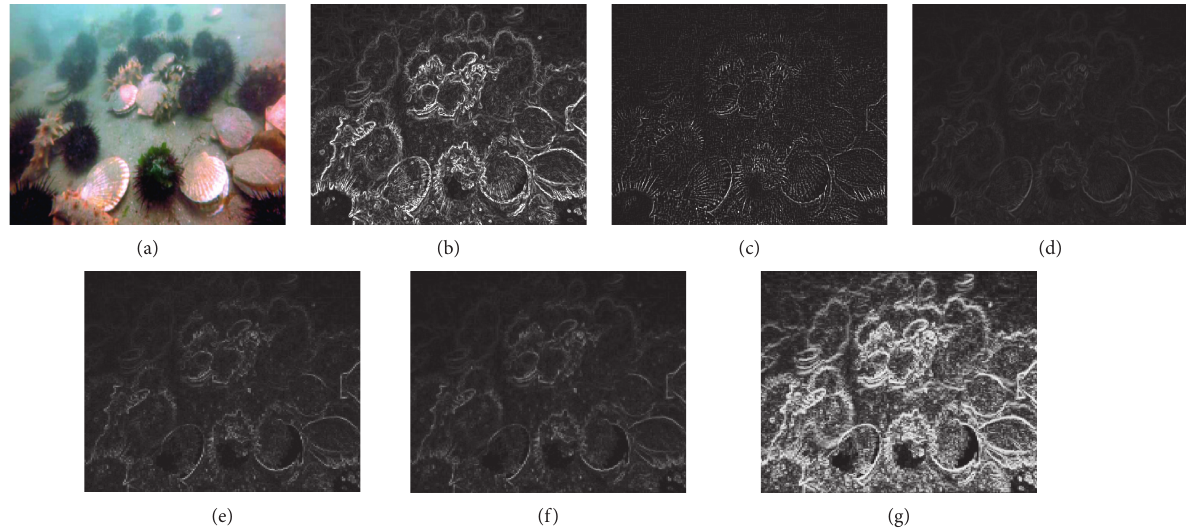
Figure 3: (a) The image of underwater sea urchins; (b) the image of Sobel operator 2-direction edge detection; (c) the image of Laplace operator single-direction edge detection; (d) the image of Prewitt operator 2-direction edge detection; (e) the image of Prewitt operator 4- direction edge detection; (f) the image of Prewitt operator 8-direction edge detection; and (g) the image of Prewitt operator 16-direction edge